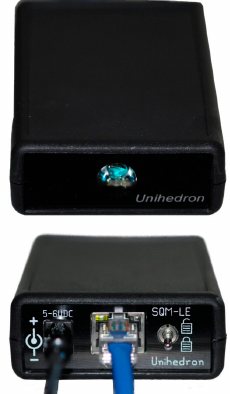
Figure 2. Sky Quality Metre - LE, source: Unihedron company.